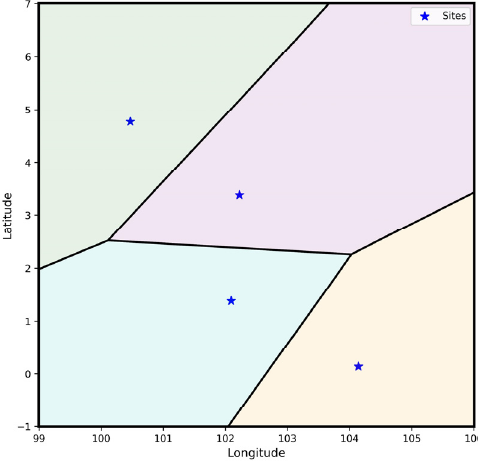
Figure 3. An example of airspace sectorization using the Voronoi diagram with four sites.